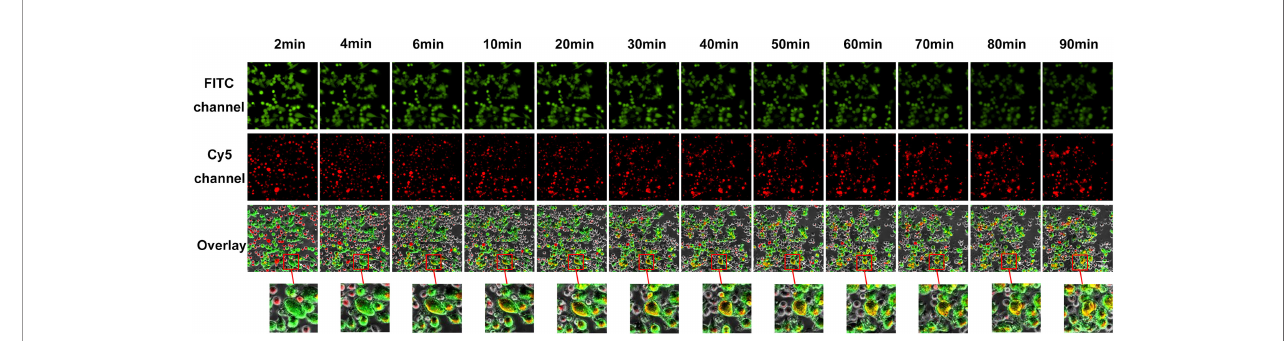
FIGURE 6 | Visual and dynamical observation of the delivery process of secretory lysosomes of SP cells to PD-L1 high MP cells. From left to right are the images from 12 sequential time points of the effect-target cell co-culture experiment. From top to bottom, the fi rst row indicates fi elds of view under the green fl uorescence (FITC) channel, the second row indicates fi elds of view under the red fl uorescence (Cy5) channel, and the third row shows the overlay of the two- fl uorescence signals. Dynamically changes can be observed following the co-culture of effector and target cells, and the red box indicates typical degranulation phenomenon, in which SP cells delivered secretory lysosomes labeled by Lyso-Tracker Red fl uorescent probe to PD-L1 high